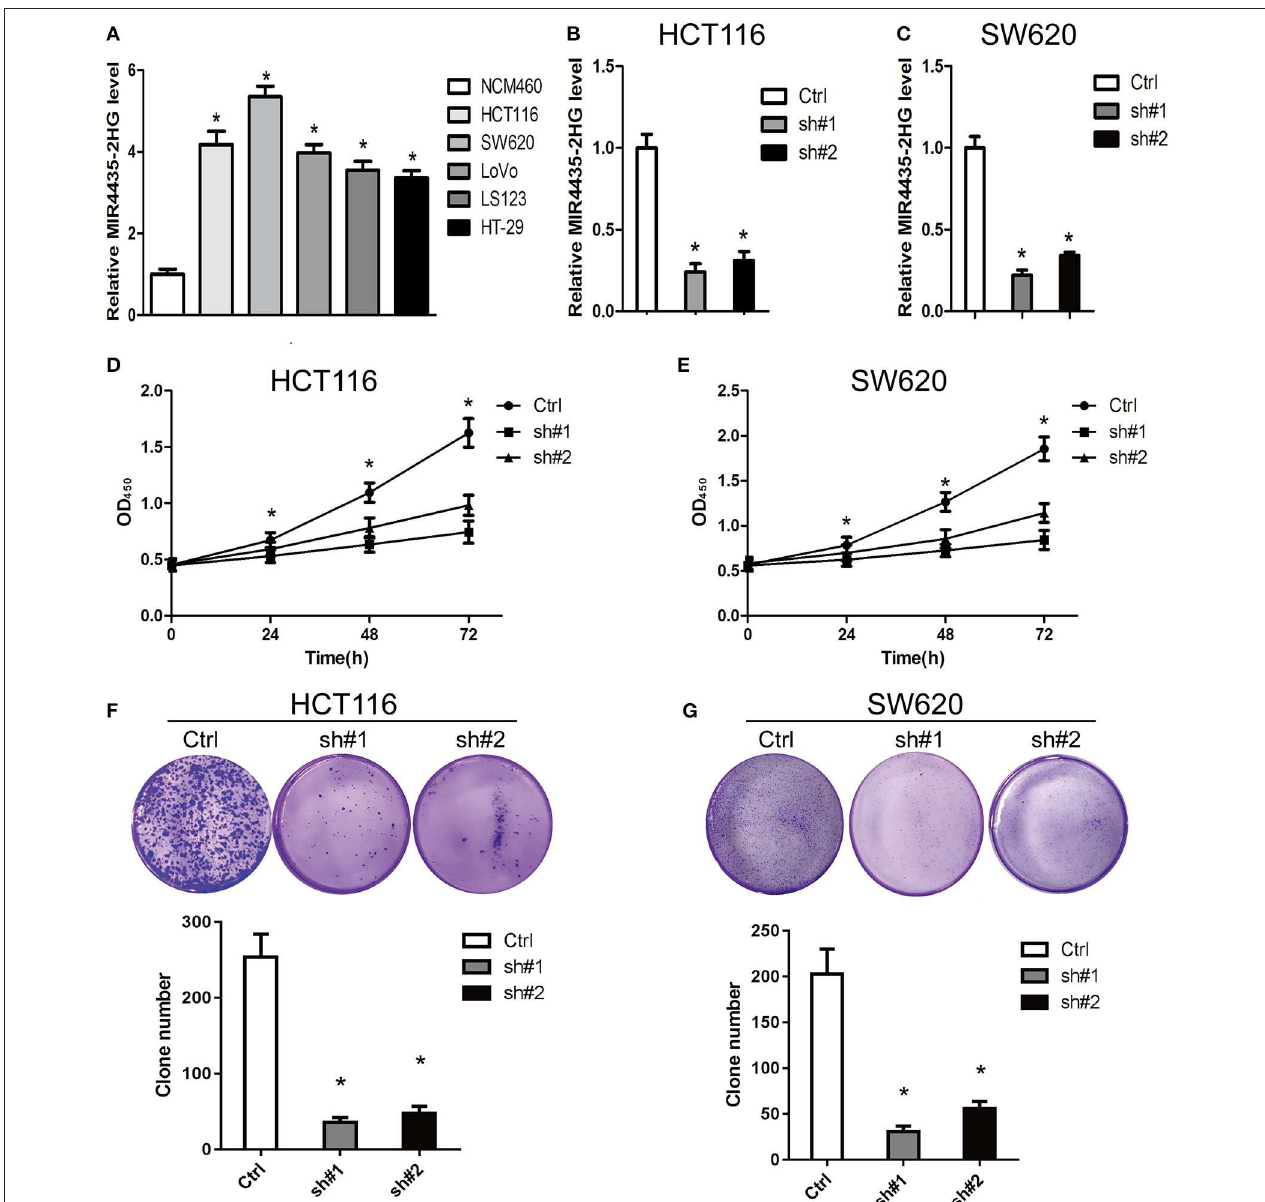
FIGURE 2 | Knockdown of MIR4435-2HG inhibited growth and proliferating process of colorectal cancer (CRC) cells. (A) Expression analysis of MIR4435-2HG in CRC cell lines. (B,C) MIR4435-2HG expression was reduced by using two short hairpin RNAs (shRNAs) targeting MIR4435-2HG in HCT116 and SW620 cell lines. * P < 0.05; n = 3. (D,E) The effect of proliferation inhibition by MIR4435-2HG knockdown in HCT116 and SW620 cells in contrast to that in their respective controls was analyzed using a CCK8 assay. * P < 0.05; n = 3. (F,G) Colony formation assays were performed to evaluate cell growth following MIR4435-2HG knockdown in HCT116 and SW620 cells. * P < 0.05; n =